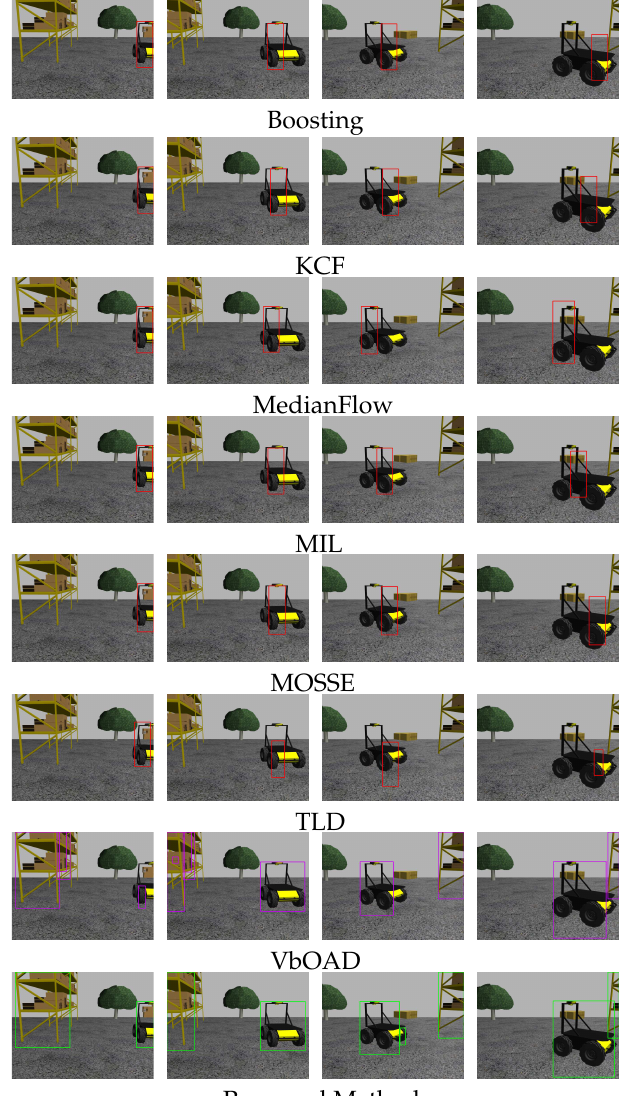
Figure 13. Comparison among the mentioned tracking algorithms with a dynamic obstacle: Husky2. All algorithms were initialized when the Husky2 became partially visible (first